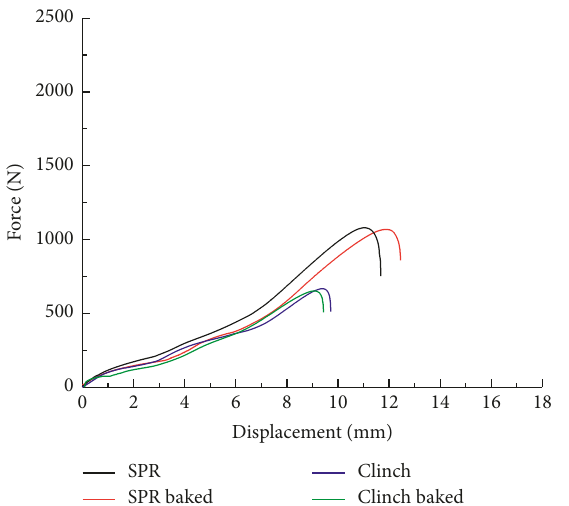
Figure 12: Comparison of cross-tension tests of SPR and clinched joints before and after the baking process at 0.083 × 10 − 3 m/s.